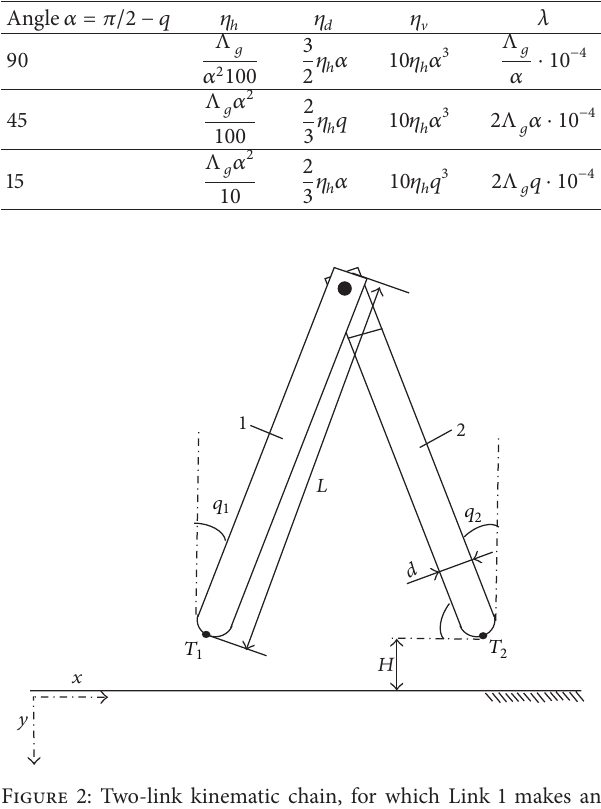
Figure 2: Two-link kinematic chain, for which Link 1 makes an angle 𝑞 1 with vertical and Link 2 makes and angle 𝑞 2 with vertical.